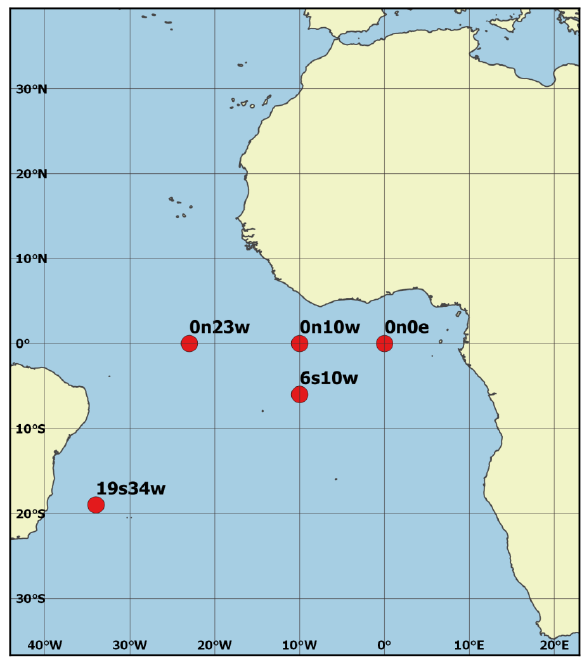
Figure 1. Location of the five PIRATA buoys used in this